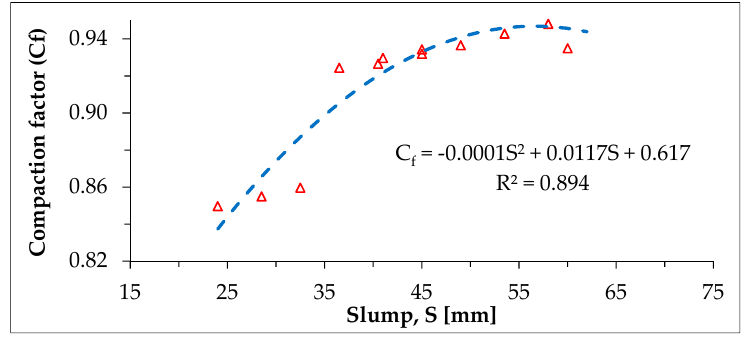
Figure 5. Relationship between slump and compaction factor.